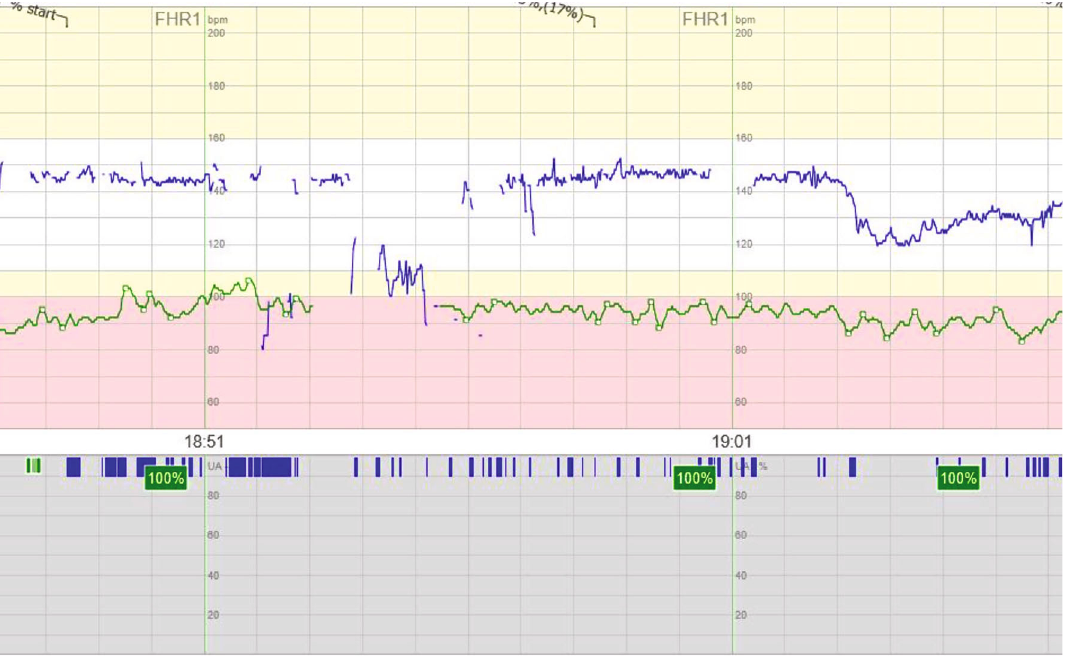
Figure 2: Patient 2 CTG at admittance to the